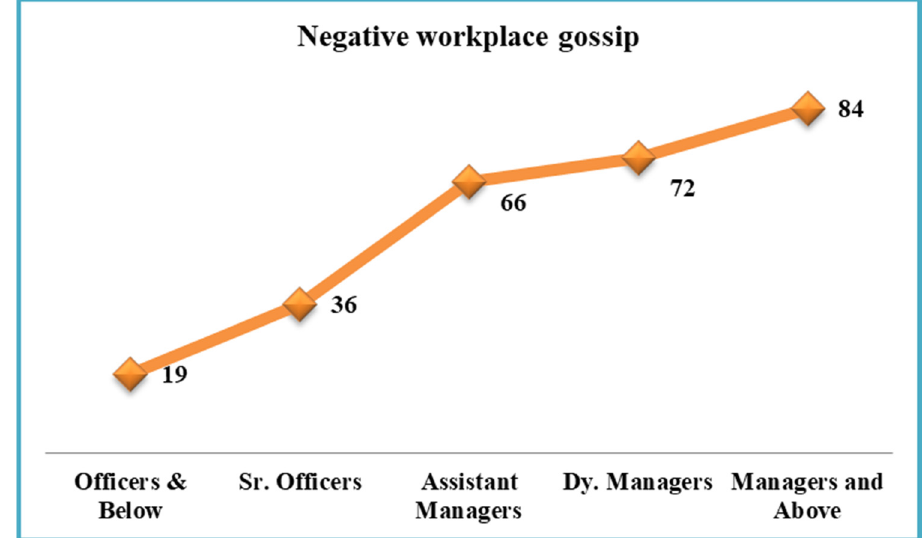
Figure 4. Hierarchy wise NWG comparison.